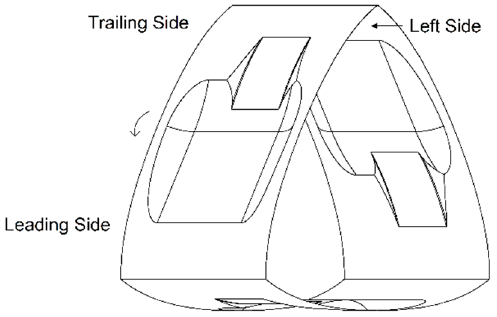
Figure 1. Rotor flanks with recess and an off-centered slot.